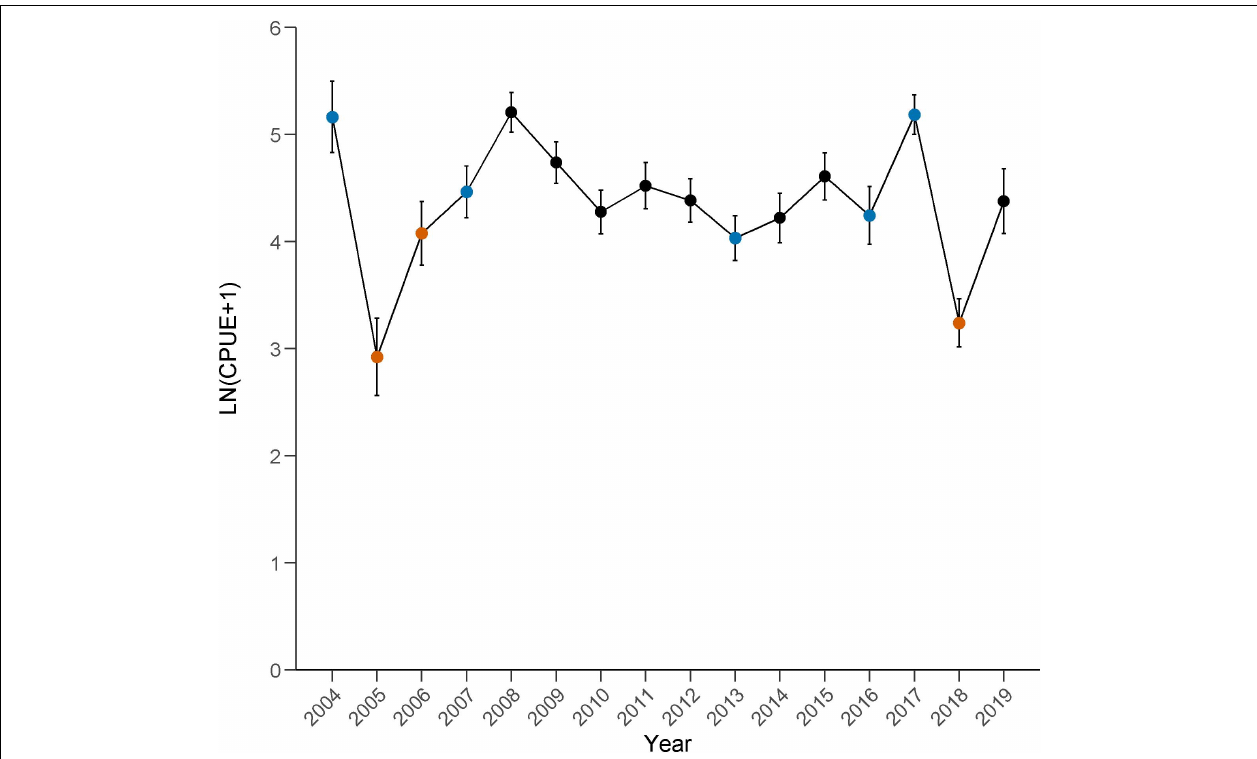
FIGURE 7 | Annual catch per unit of effort (CPUE; mean ± se) of bottlenose dolphin prey species (excluding Clupeidae spp.) caught in the Sarasota Bay study area during 2004–2019. Symbols: • = summer red tide years, • = winter red tide years, • = no known red tide disturbance